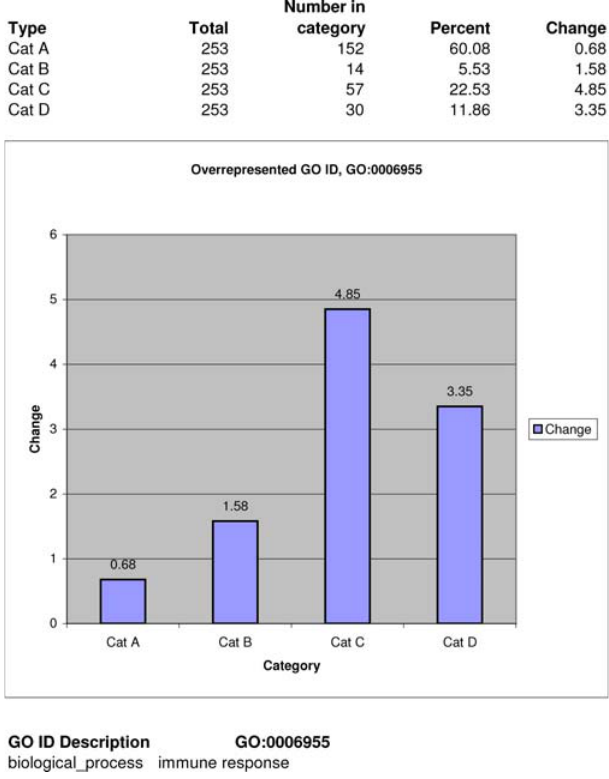
Figure 6. Distribution of TSSs for Transcripts Related to Immune Response through GO:0006955 There are 1.58-, 4.85-, and 3.35-fold more transcripts having TSS types B, C, and D than one would expect based on the proportion of transcripts in these groups in our reference mouse data. Enrichment is statistically significant for types C and D based on Bonferroni corrected p -values obtained by the right-sided Fisher’s exact test (Table 5). DOI: